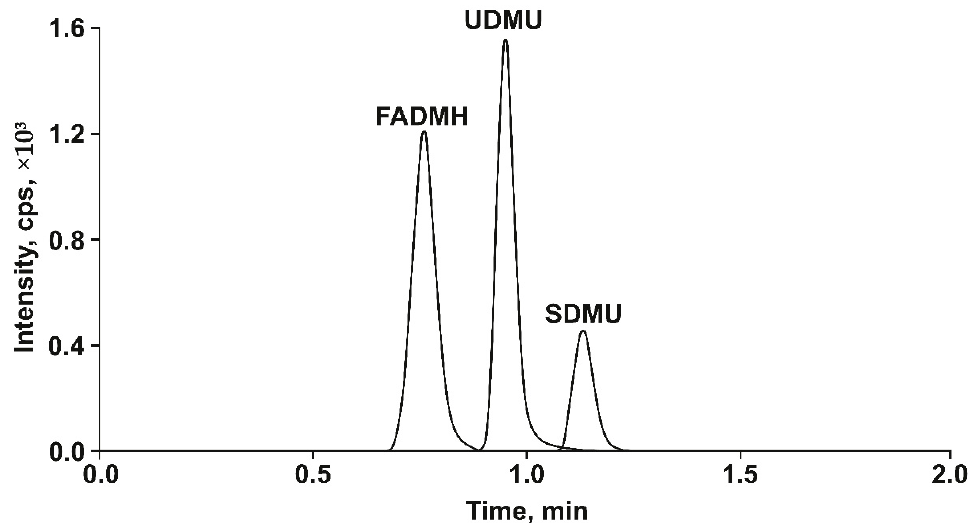
Figure 1. The SFC-MS/MS chromatogram of the model mixture of analytes (3 µ g mL − 1 of FADMH, 0.5 µ g mL − 1 of UDMU and SDMU) obtained under the optimized conditions.